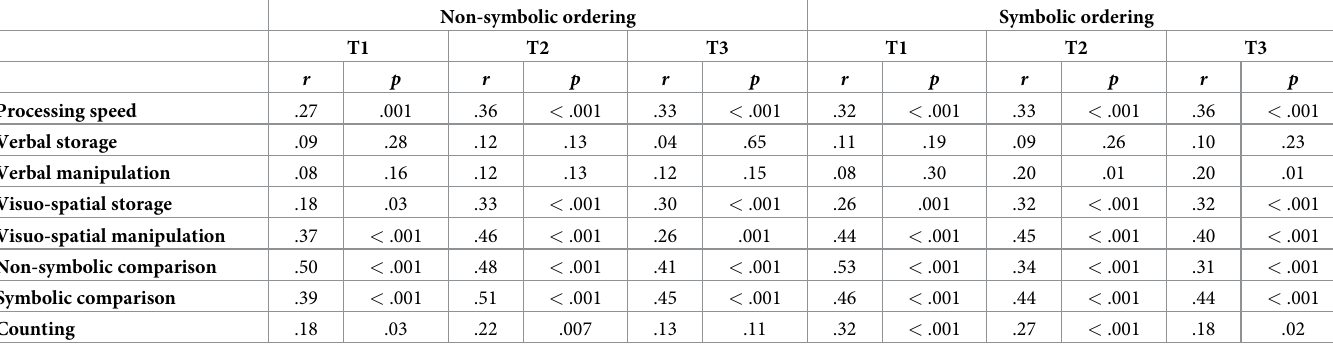
Table 3. Bivariate correlations between predictors and the order processing